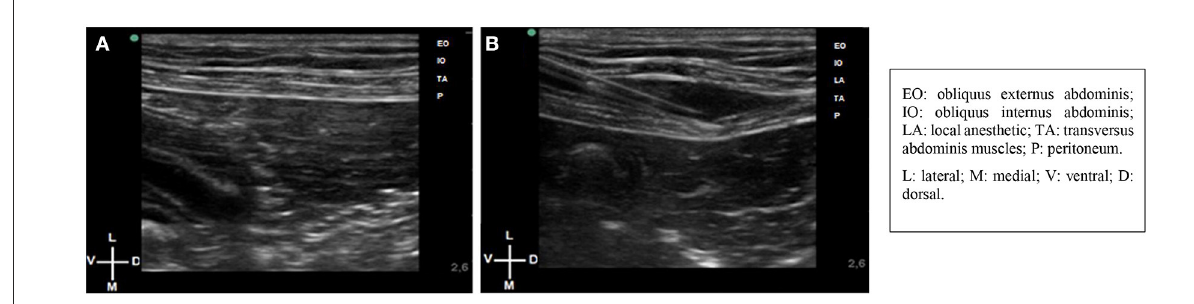
FIGURE1 (A) Ultrasound images of the retrocostal region during the abdominal wall scanning in dog. (B) In plane technique. The Tuohy needle reaching the transverse abdominis plane, located between the obliquus internus abdominis and transversus abdominis muscles.